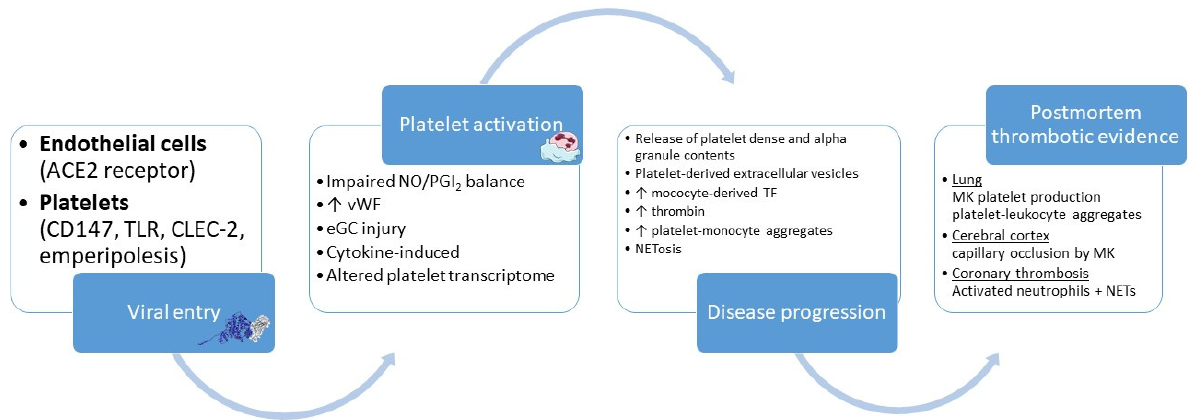
Figure 2. SARS-CoV-2 infection and platelet activation. Severe acute respiratory syndrome coronavirus 2 (SARS-CoV-2) enters endothelial cells through the angiotensin converting enzyme 2 (ACE2) receptor or platelets through CD147, toll-like receptors (TLR), C-type lectin-like receptor 2 (CLEC-2), or via emperipolesis. Several mechanisms are involved in the consequent platelet activation, which leads to the release of platelet granule content, the overexpression of tissue factor (TF), the formation of platelet-leukocyte aggregates, and neutrophil extracellular traps (NETs). Ultimately, the rising severity of the disease could lead to death with significant findings of thrombosis being evidenced in postmortem lung, brain, and heart studies. NO: nitric oxide, vWF: von Willebrand factor, eGC: endothelial glycocalyx, MK: megakaryocytes.